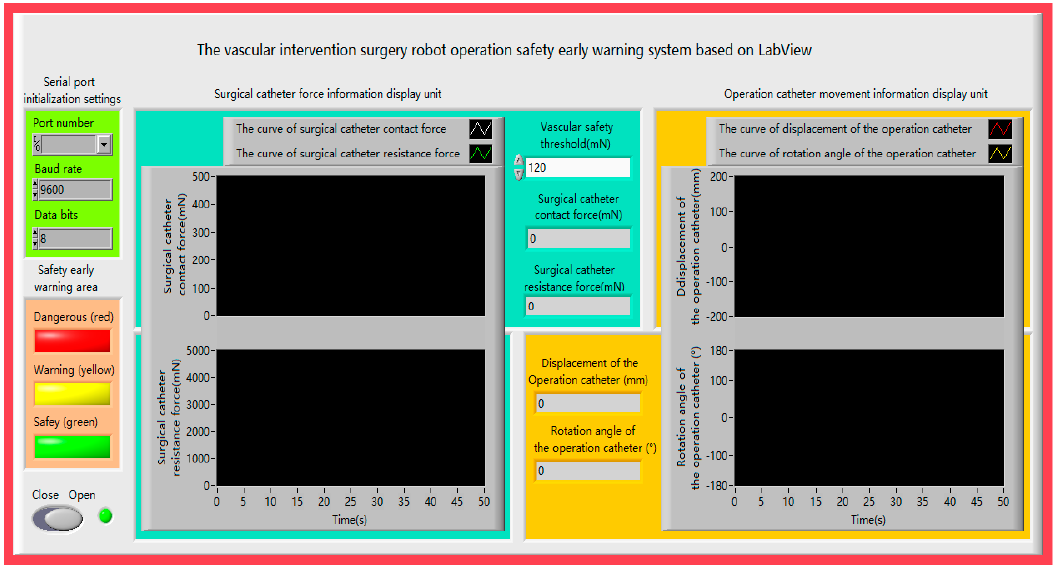
Figure 4. The operation safety early warning system.